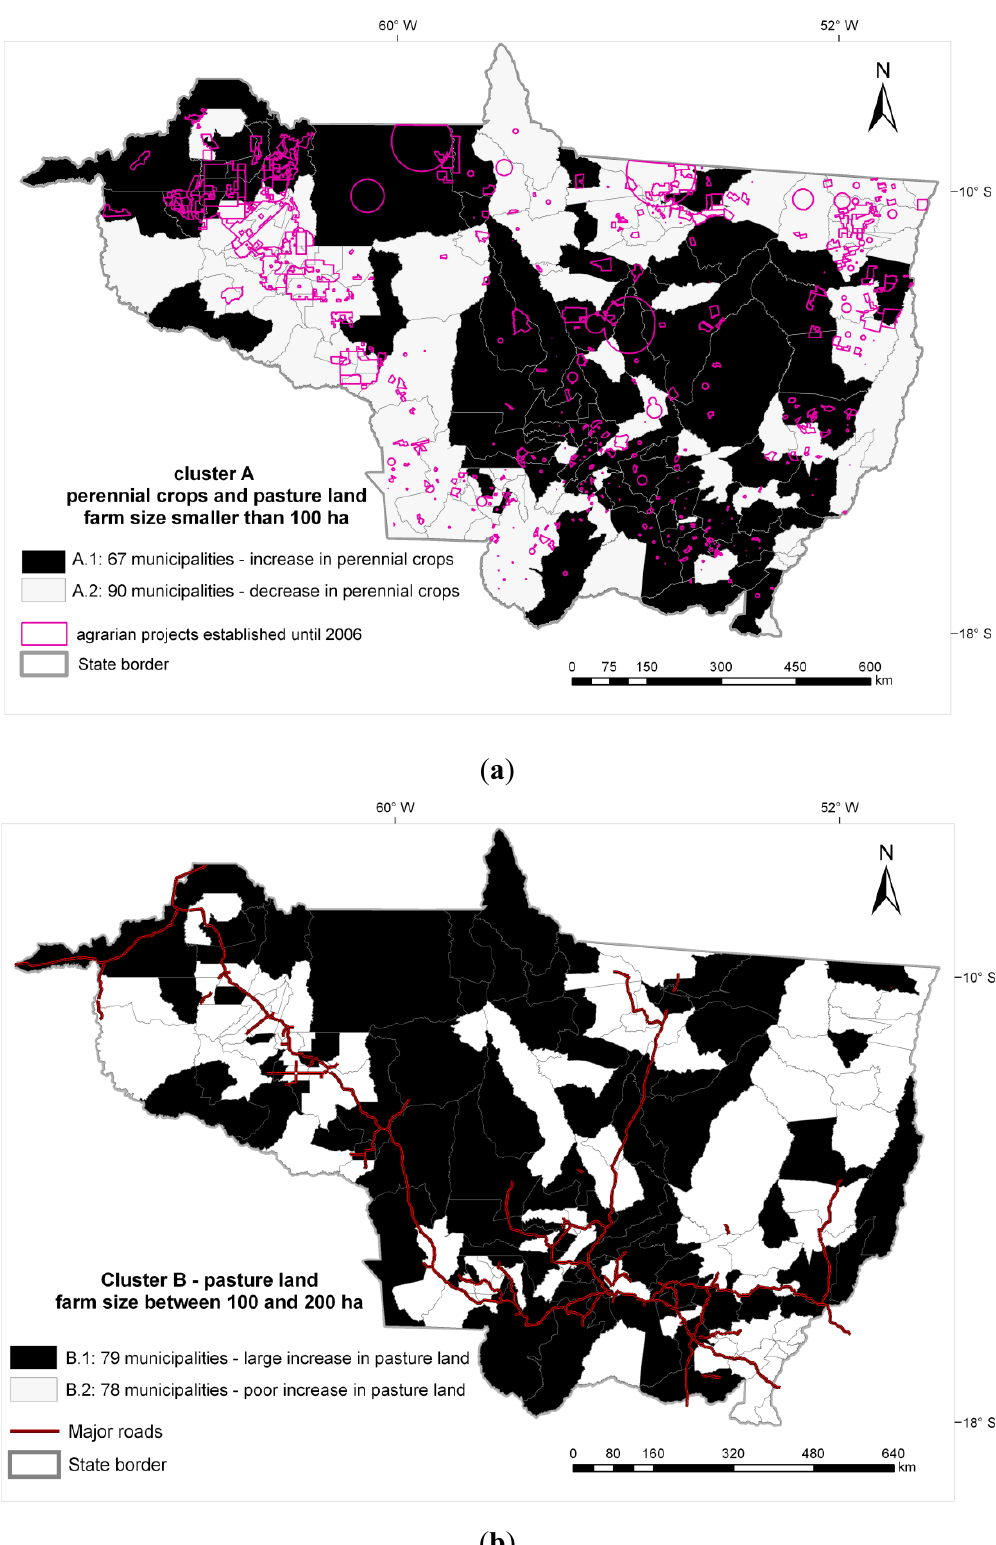
Figure 4. Clusters of municipalities based on changes in land use and land use intensification indicators for different categories of farm size in Rondônia and Mato Grosso between 1996 and 2006. ( a ) Cluster A: farms smaller than 100 ha; ( b ) Cluster B: farms between 100 and 200 ha; ( c ) Cluster C: farms between 200 and 1000 ha; ( d ) Cluster D: farms larger than 1000